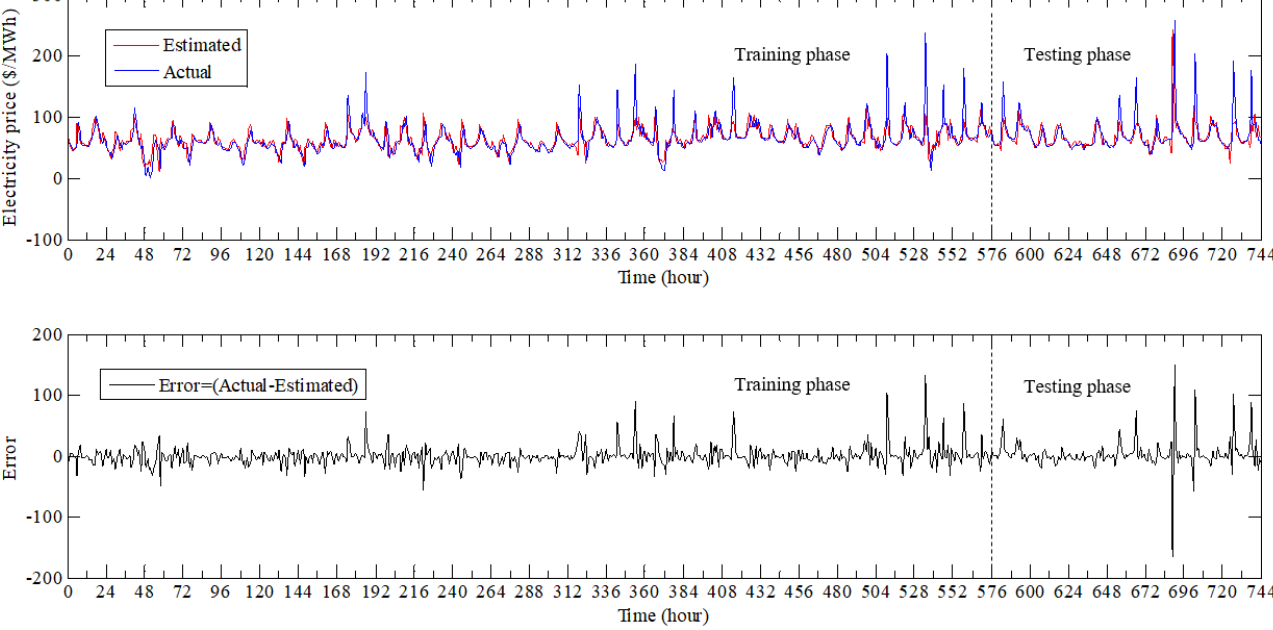
Figure 7. The evaluation of the performance throughout training at the designing and testing phases of ANFIS-BSA and its corresponding error of EPF in August 2018 for QLD.